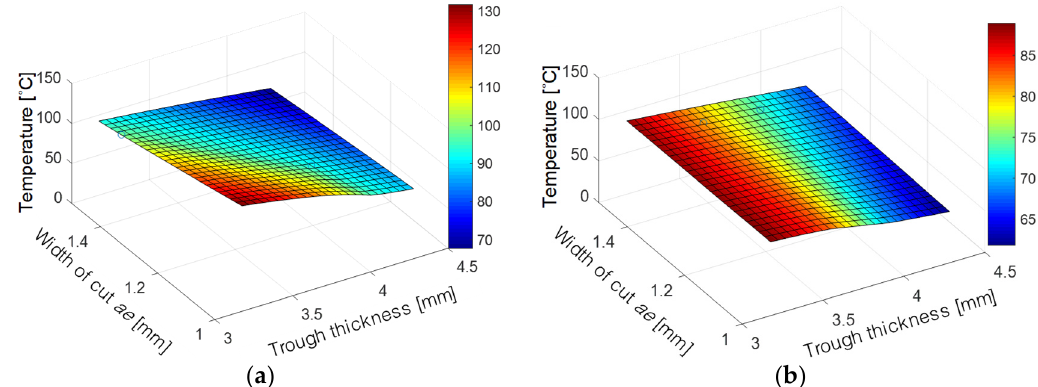
Figure 11. 3D surf mesh vertical cutting temperature for thermocouples 2-5-7-9 and an ft of 0.05 mm/tooth, ae of 1 mm: ( a ) temperature trend for tool2; ( b ) temperature trend for tool3 along the stack depth.